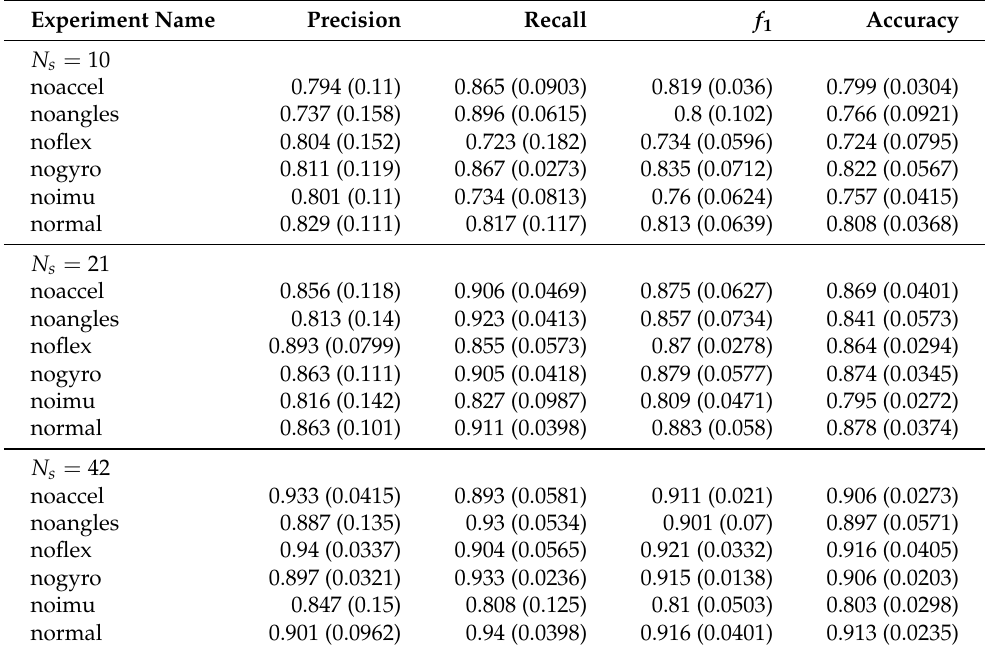
Table A4. Five-fold cross validation results for anomaly classification.